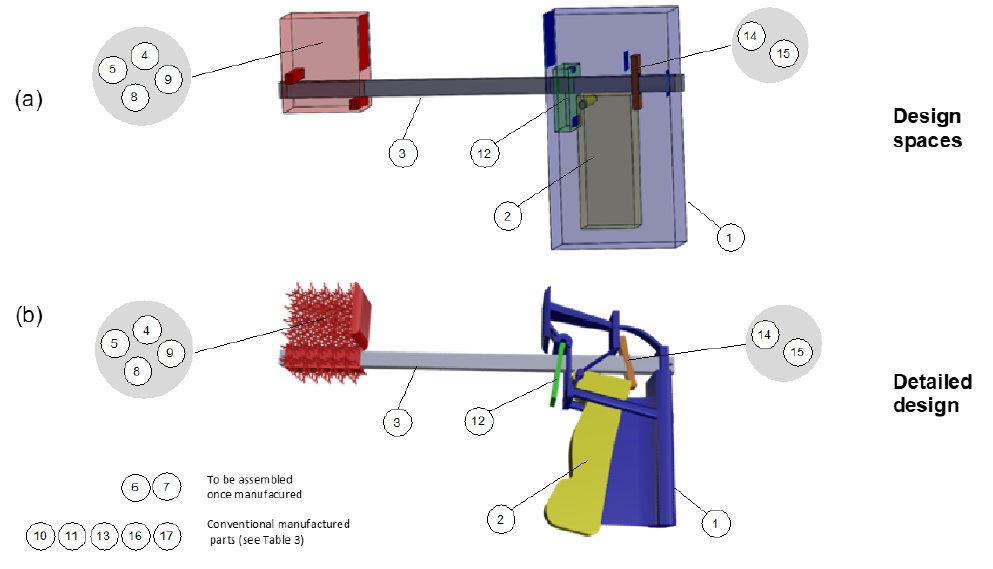
Figure 10. ( a ) Design spaces definition and ( b ) emergence of the detailed geometry of the case